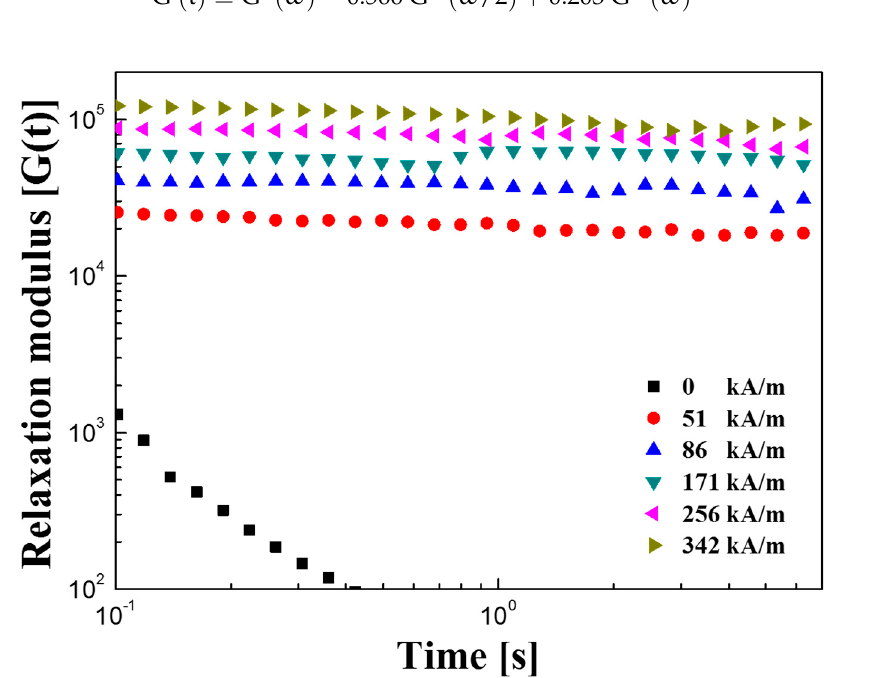
Figure 11. Shear relaxation modulus G(t) of Fe 3 O 4 /POA-based MR suspension.